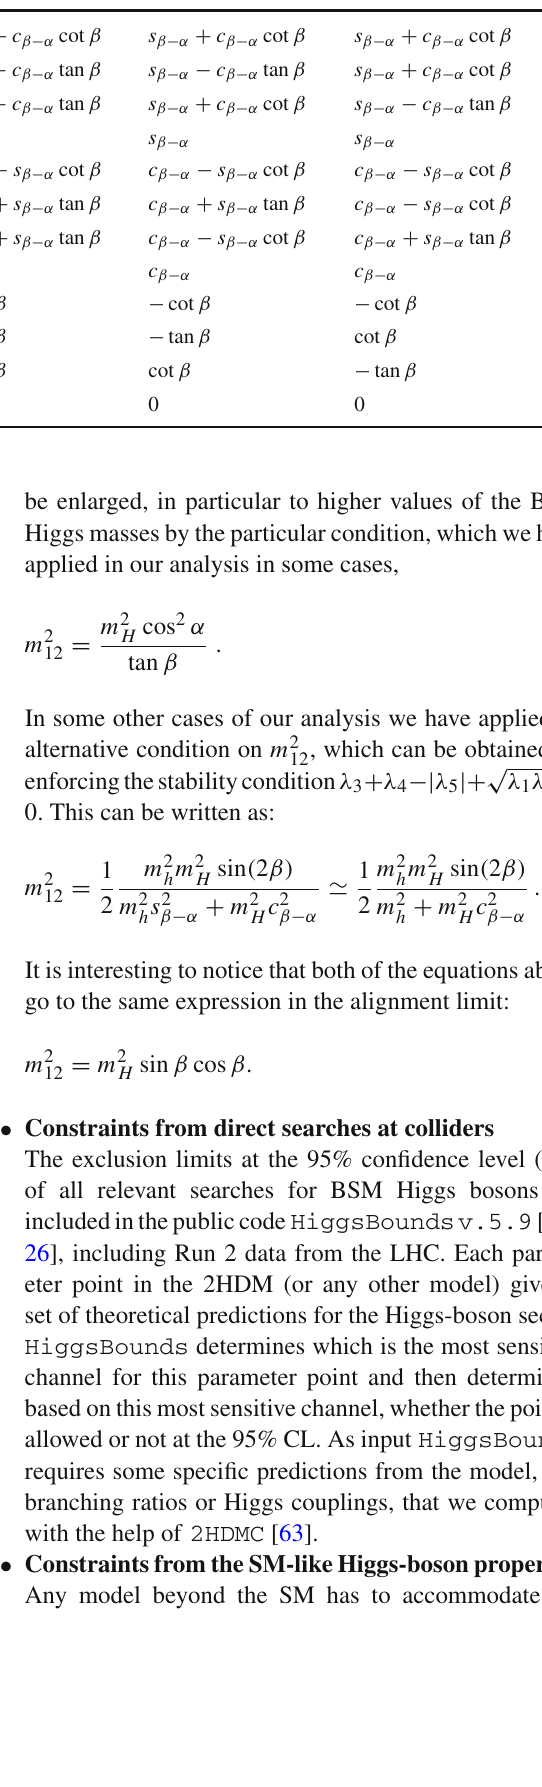
appearing in the couplings of the Higgs bosons to fermions, ξ f , and to gauge-bosons, h , H , A ξ V , according to Eq. (4), in h , H , A the four types of the 2HDM considered here